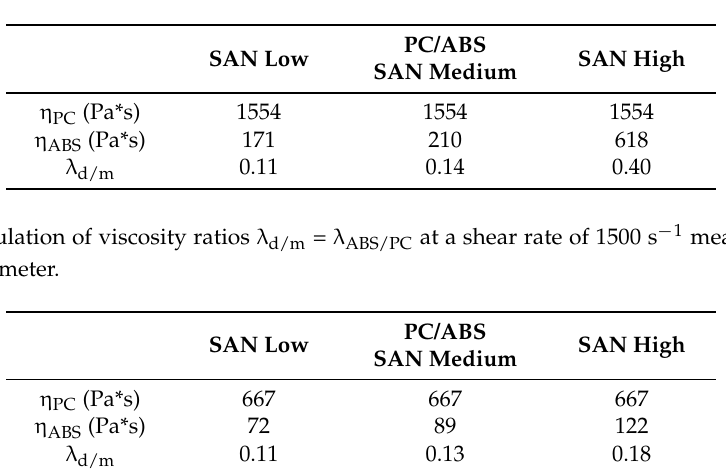
Table 2. Calculation of viscosity ratios λ d/m = λ ABS/PC at an angular frequency of 100 rad/s measured with a rotational rheometer with parallel plate geometry.